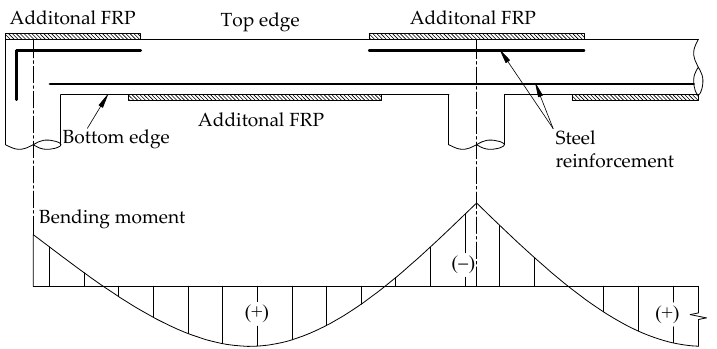
Figure 1. Externally bonded FRP strengthened slab at conventional locations.